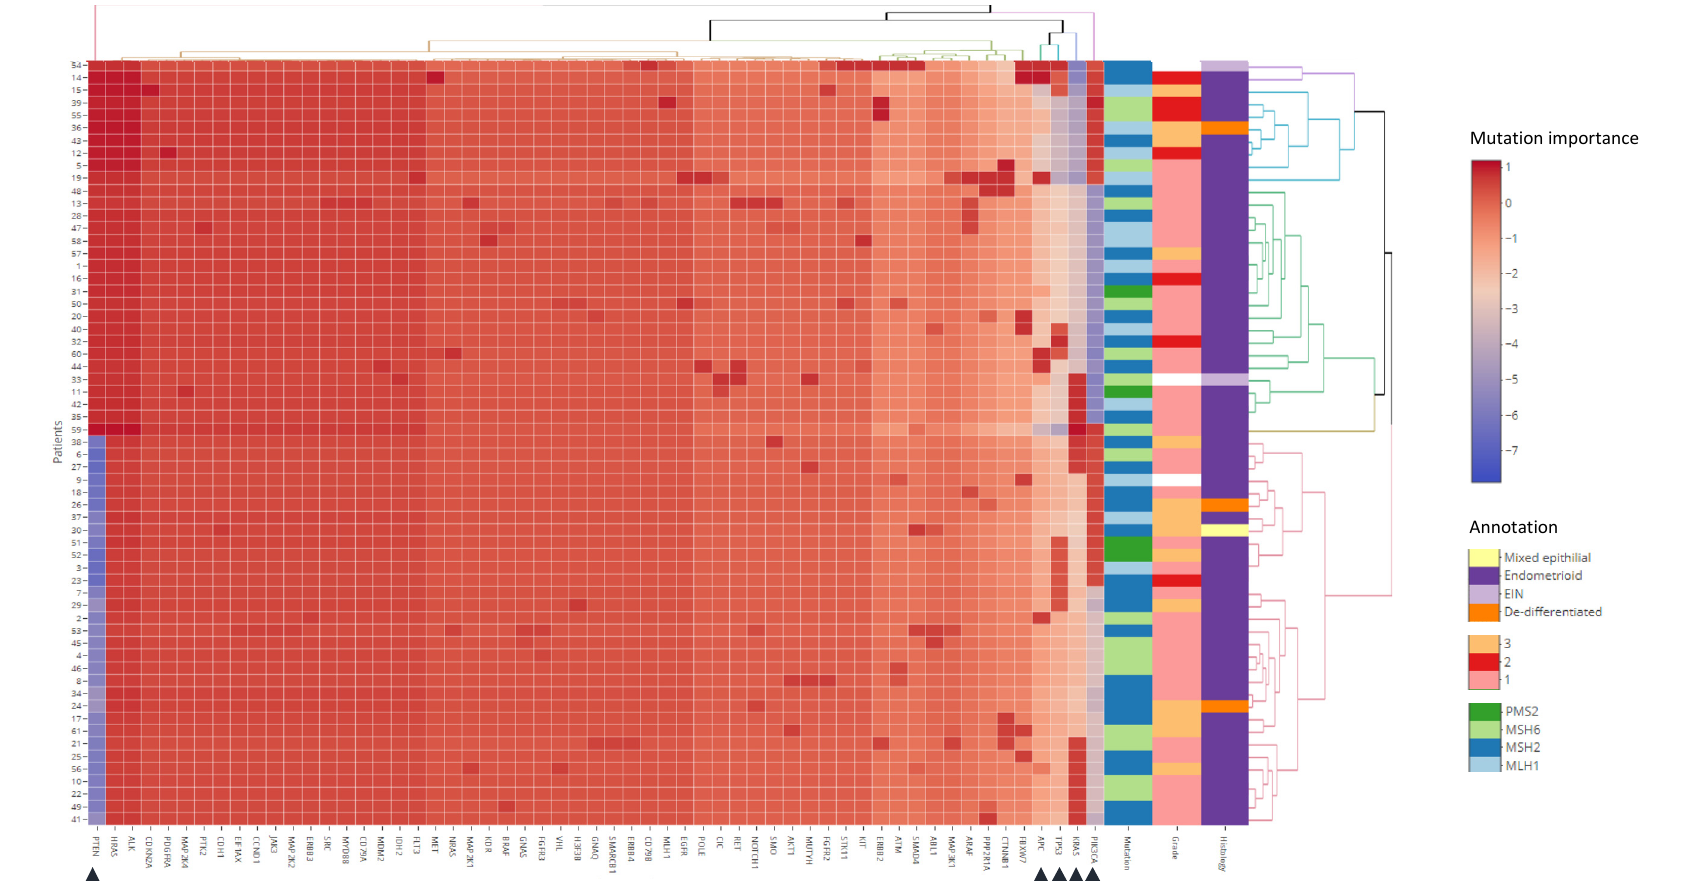
Figure 4. Mutation profiles within LS-EC. A panel of 56 genes classified by ‘ranked severity mutation’ for 61 LS-EC patients. Clinical annotations for Lynch pathogenic variant ( PMS2 ; MSH6 ; MSH2 ; MLH1 ), grade, histological subtype are provided as the rightmost columns. Intensities represent standardised and scaled signatures per patient observations (rows). Six principal dendrogrammatic clusters of genetic mutational signatures were observed indicative of genomic assault substructure within this LS-EC cohort. Gene clustering present mutations in PTEN , PIK3CA , KRAS , TP53 , and APC (triangles) as the most important events in the gene target panel for patients with Lynch Syndrome. No subclusters were found to associate with Lynch genotype, disease grade, or histology.